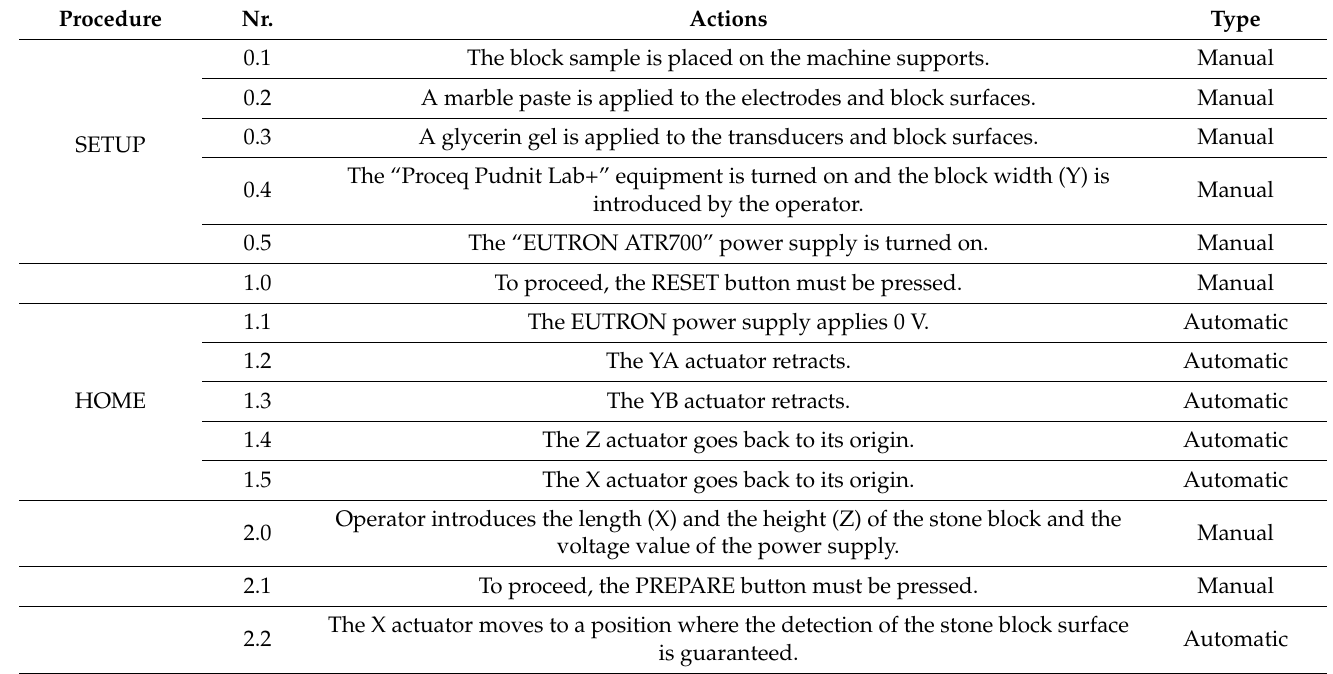
Table 3. Machine